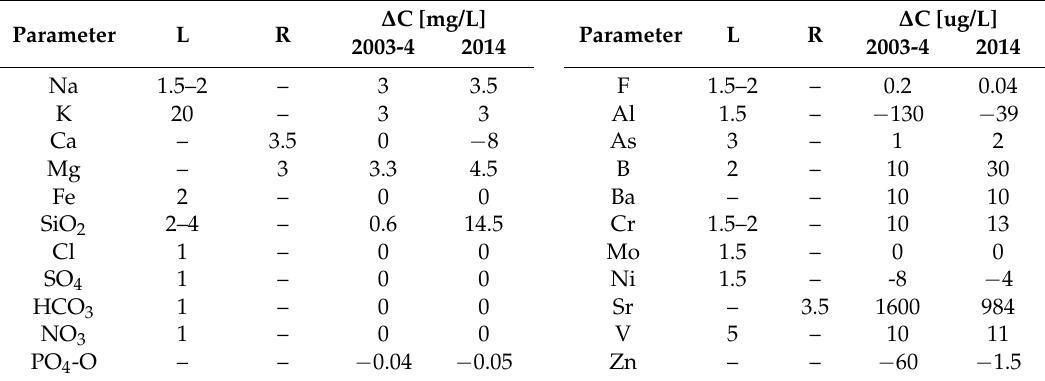
Table 4. Interpretation of water quality observations at the pilot, in terms of retardation factor (R), Leach factor (L) and (semi)permanent concentration change after break-through ( ∆